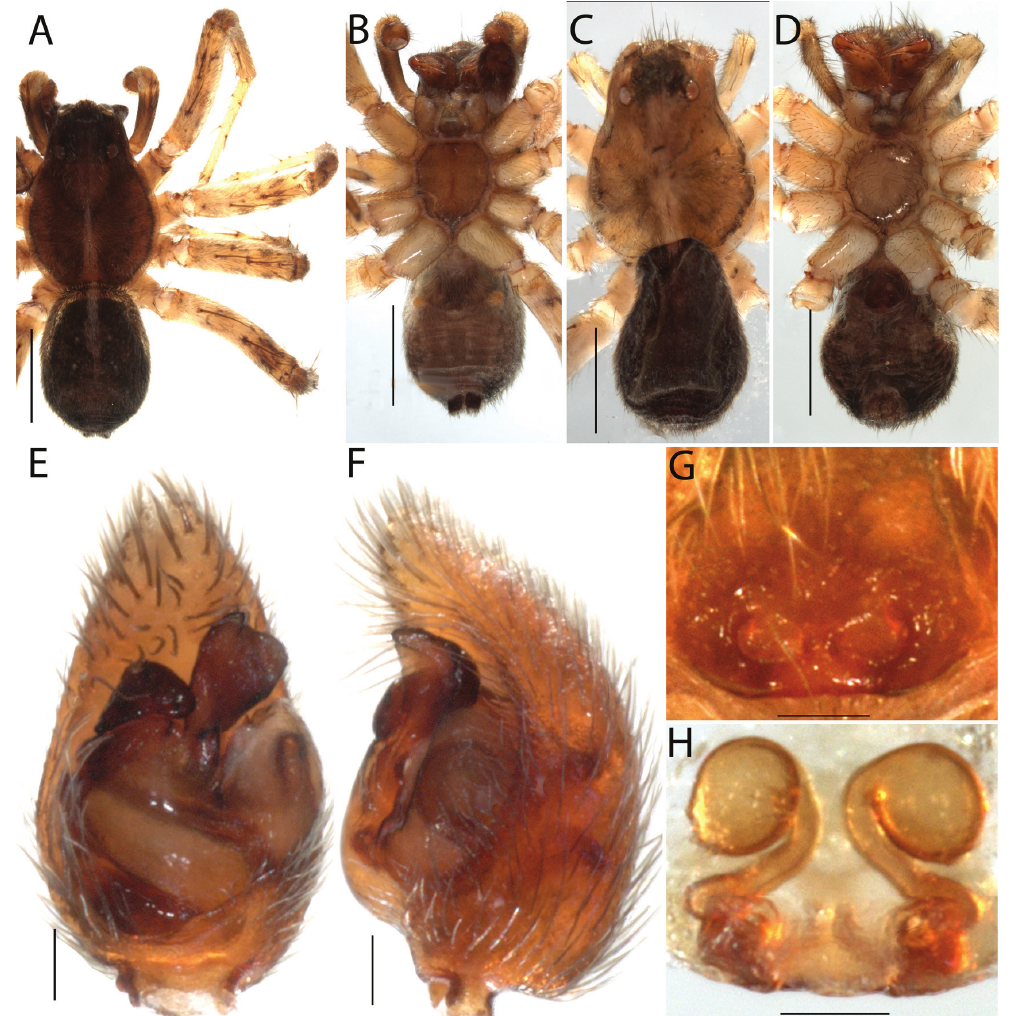
Figure 16. Artoria comleroi sp. n. , male holotype (AM KS128078), female paratype (AM KS122431): A , male habitus, dorsal view; B , male habitus, ventral view; C , female habitus, dorsal view; D , female habitus, ventral view; E, male pedipalp, ventral view; F , male pedipalp, retrolateral view; G , epigyne, ventral view; H , epigyne, dorsal view. Scale bars: habitus 1.0 mm; pedipalp, epigyne 0.1